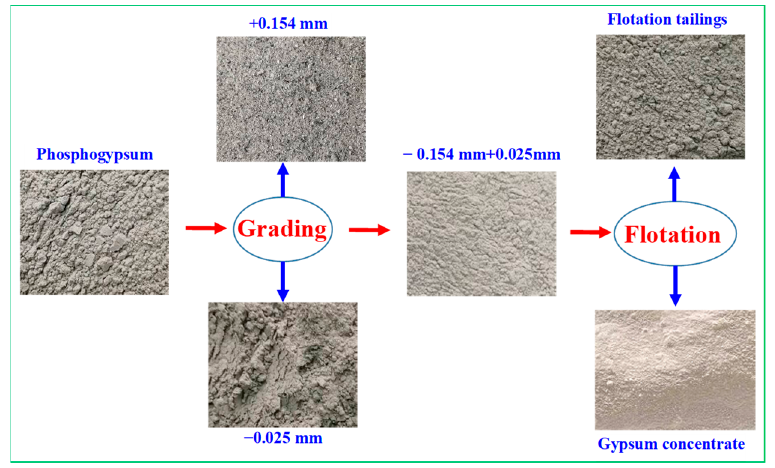
Figure 10. Photographs of characterization analysis of purification process of phosphogypsum.